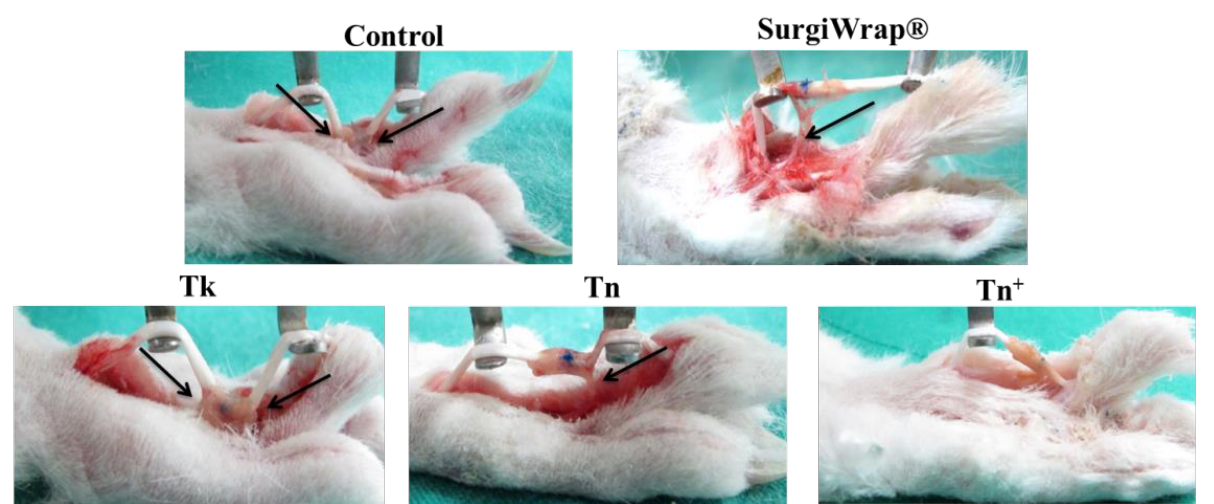
Figure 11. The rabbit flexor tendons observed three weeks post-operatively. Note the substantial peritendinous adhesions (black arrows) in the control and Tk groups, with fewer adhesions observed in the SurgiWrap ® and Tn groups. Peritendinous adhesions are absent in the Tn + group.